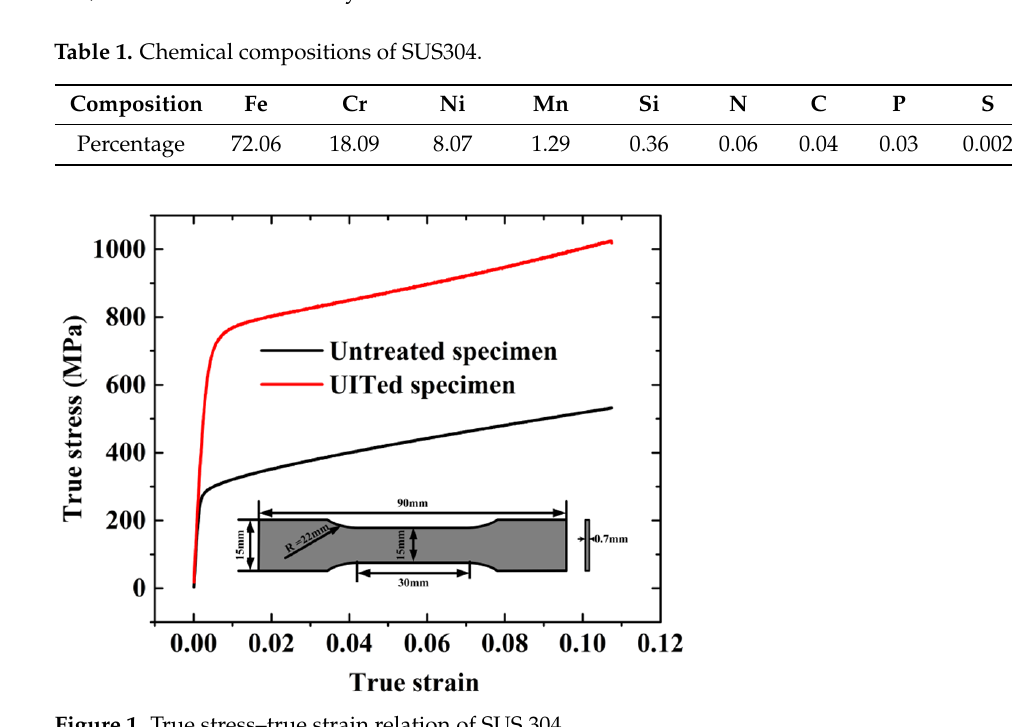
Figure 1. True stress – true strain relation of SUS 304. Table 2. Tensile properties of untreated and nanocrystallized 304 stainless steel.